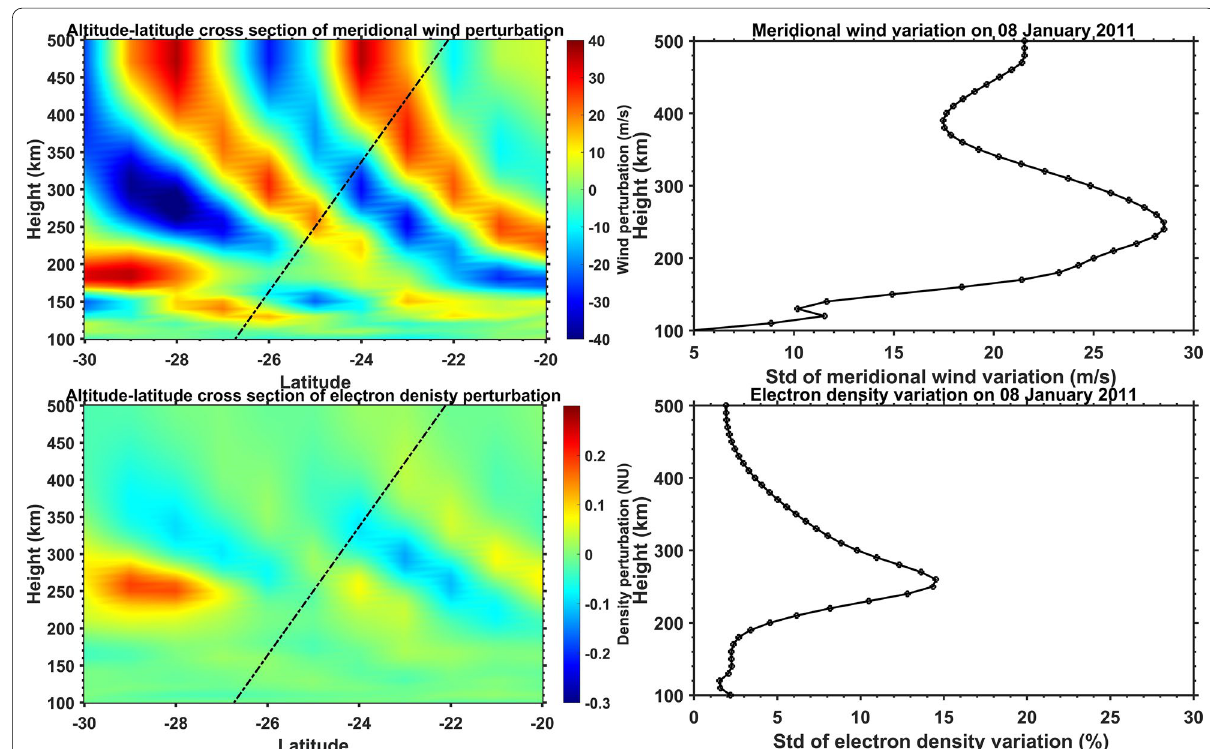
Fig. 9 Results of GAIA simulation at South Africa at 13:42 LT on 8 January, 2011: (Left) altitude–latitude cross section of (top) meridional wind and (bottom) electron density perturbations and altitude–latitude variation of a magnetic field (taken from GAIA model) line with constant dip angle (~ 45°) at 250 km is also shown (black dotted lines) in these figures. (Right) Altitude profiles of standard deviation of (top) meridional wind and (bottom) electron density variations. The standard deviations are averaged over 20–30° S